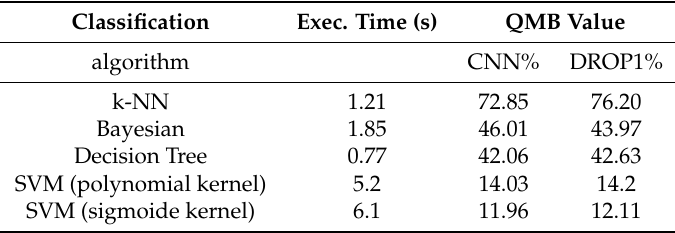
Table 4. QMB analysis for every classifier along with the previously identified PS